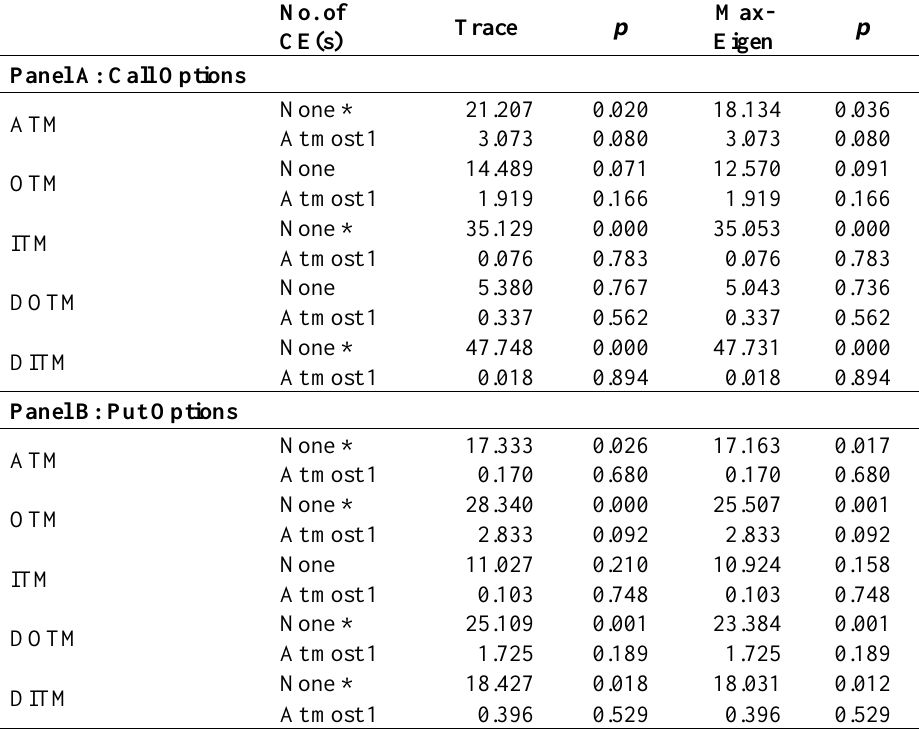
Table 1: Integration Between the Options and the Stock Markets